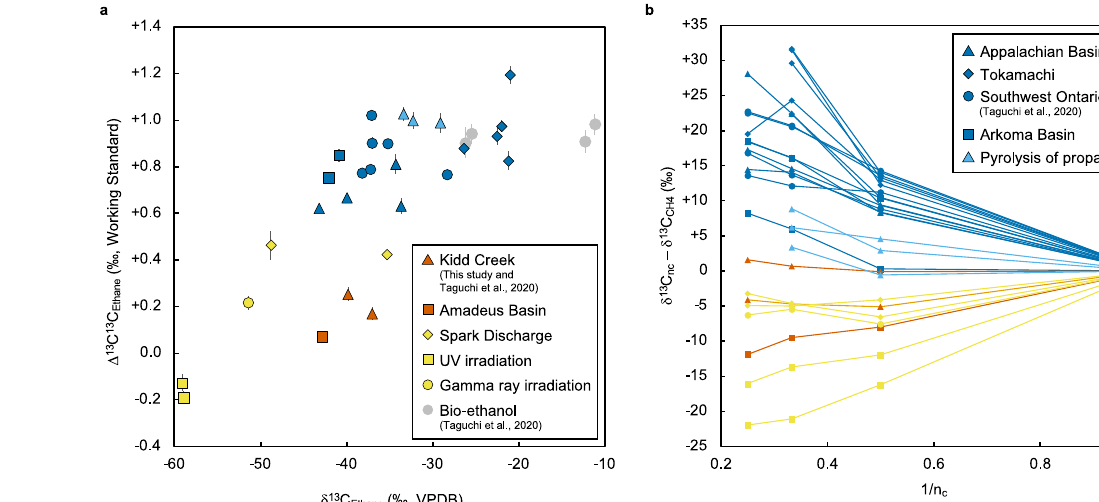
Blue symbols represent proposed thermogenic gases, and orange represent pro- posed abiotic gases. The error bars are the standard error of the mean. The ana- lytical uncertainty for the δ 13 C value is within the symbol. b Inverse of carbon number ( n c ) of individual hydrocarbon versus its carbon isotope composition relative to methane ( δ 13 C CH4 ). The analyticaluncertaintyfor the δ 13 C value is within the